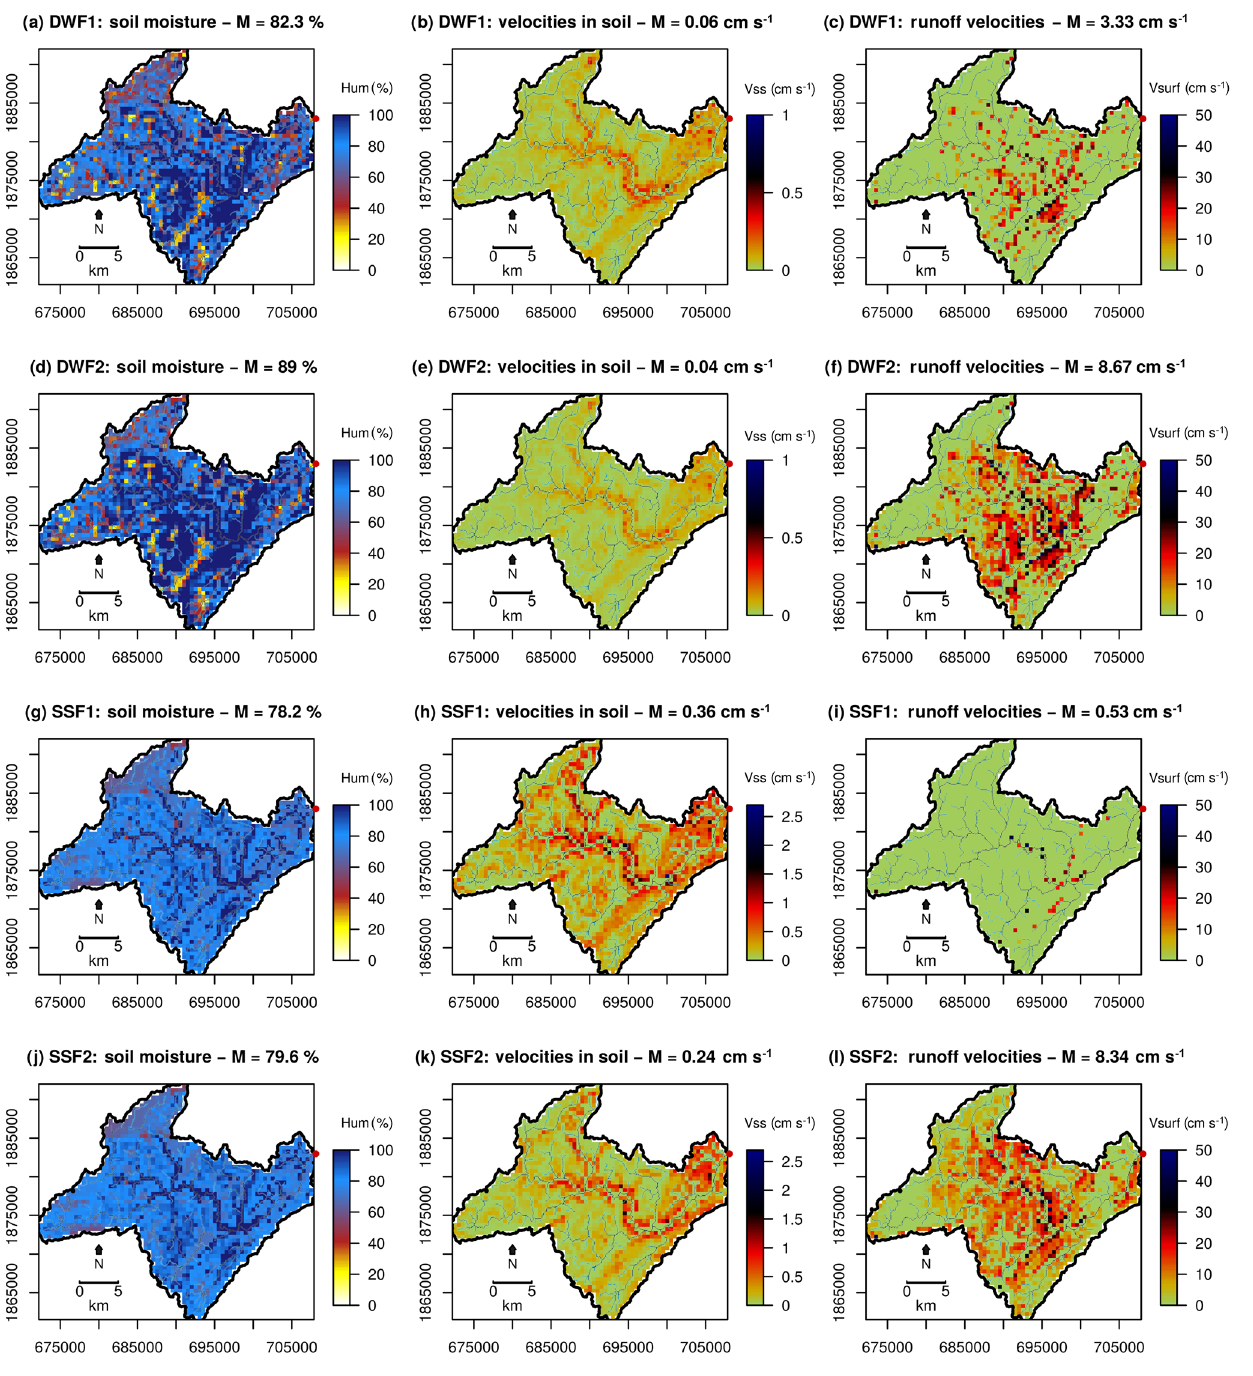
Figure 13. Spatialised outputs for a given moment during the event of 18 October 2009 for the Hérault at Saint-Laurent-le-Minier (during the development of the flood, where Q = 74m 3 s − 1 ). (a, d, g, j) soil moisture conditions simulated, respectively, by the configurations DWF1, DWF2, SSF1, SSF2. (b, e, h, k) discharges in the soil simulated, respectively, by the configurations DWF1, DWF2, SSF1, SSF2 (NB: different colour scheme). (c, f, i, l) surface flow velocities simulated, respectively, by the configurations DWF1, DWF2, SSF1,